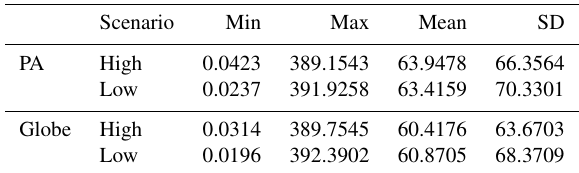
Table 1. Comparison of pathways for invasive plant species (IPS) between protected areas (PAs) and global regions based on the map